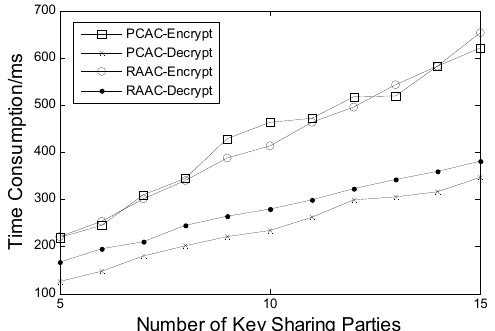
Figure 7. Time Consumption in the Encrypt and Decrypt Phase.